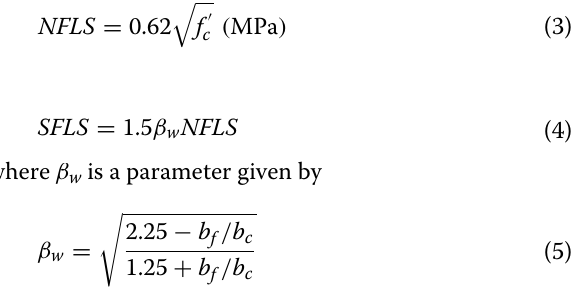
Fig. 8 Instrumentation layout and test setup for beams with center‑point loading: a sensor locations for unstrengthened beam BC‑N‑CPL, b sensor locations for beam BS1‑O1‑CPL strengthened with scheme‑1, c sensor locations for beam BS2‑O2‑CPL strengthened with scheme‑2, and d test